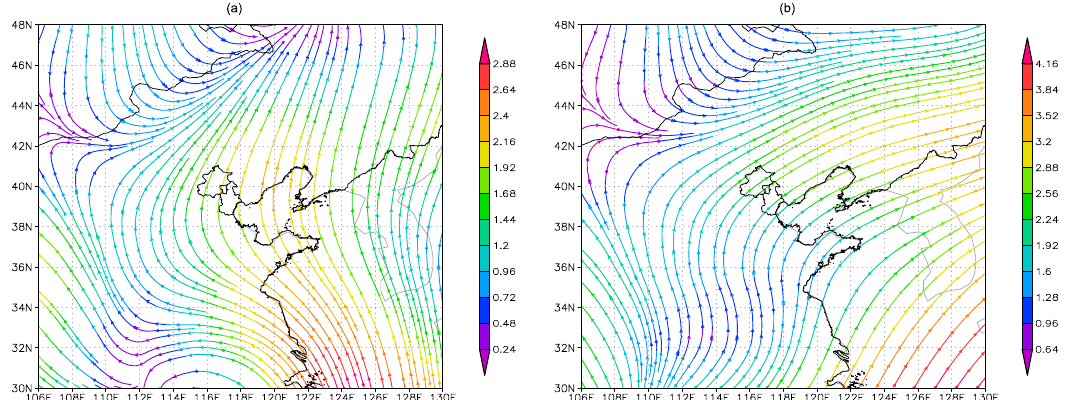
Figure 3. 1000 hpa ( a ) and 850 hpa ( b ) average wind patterns in summer.